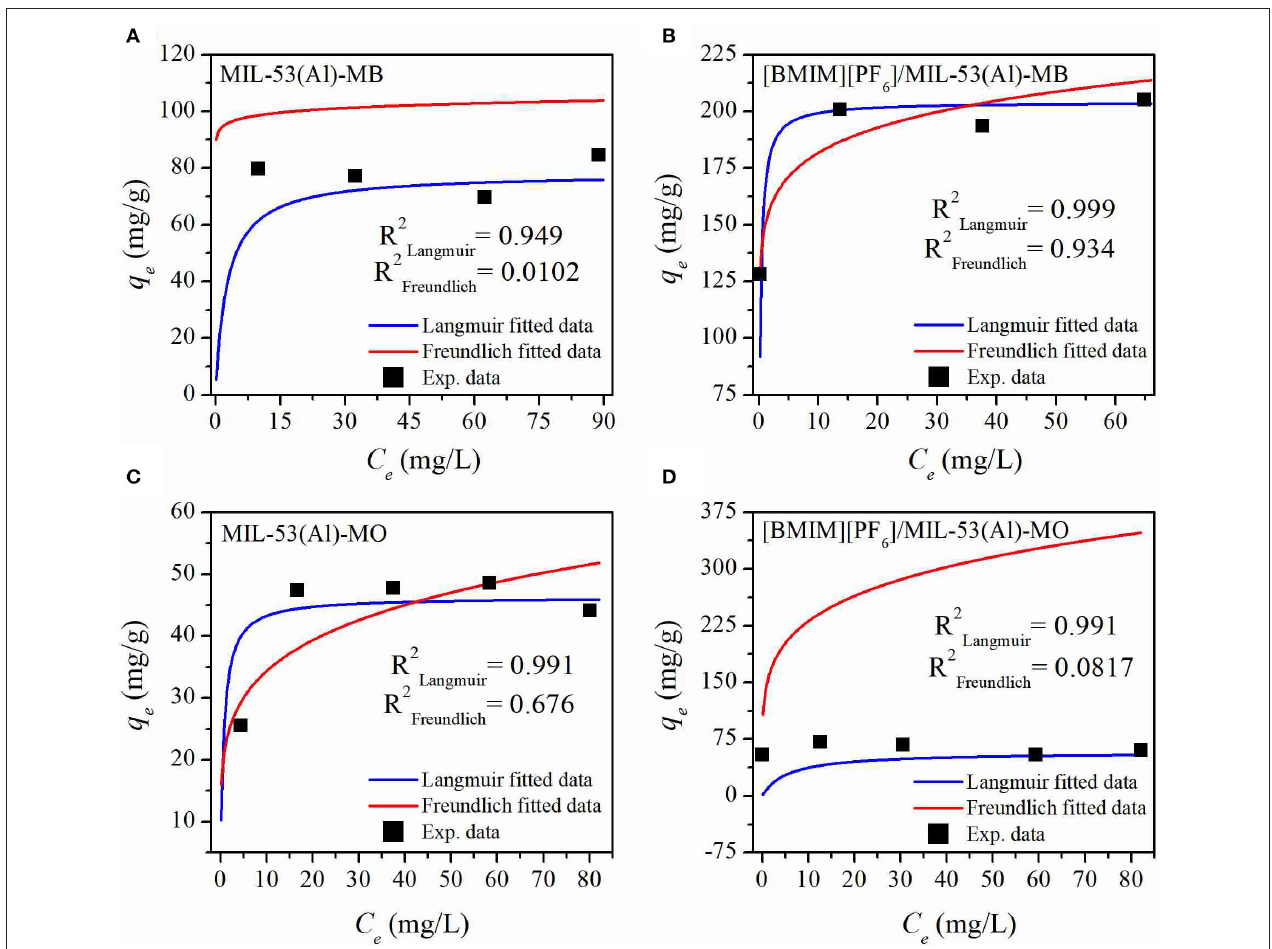
FIGURE 5 | MB (A,B) and MO (C,D) adsorption isotherms of MIL-53(Al) (A–C) and [BMIM][PF 6 ]/MIL-53(Al) (C,D) . MB, methylene blue; MO, methyl orange.